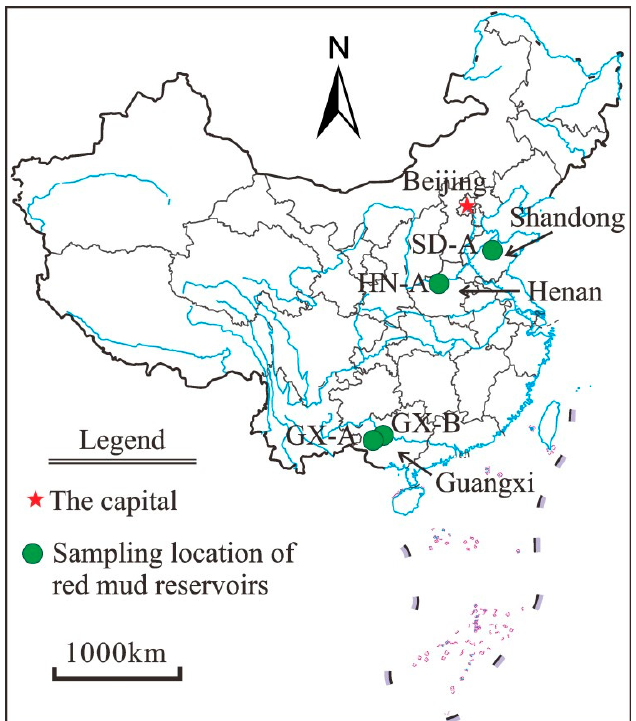
Figure 1. Locations for red mud and leachate sampling of the current study. Table 2. Sampling program of red mud and its associated leachate from the red mud reservoirs in China.